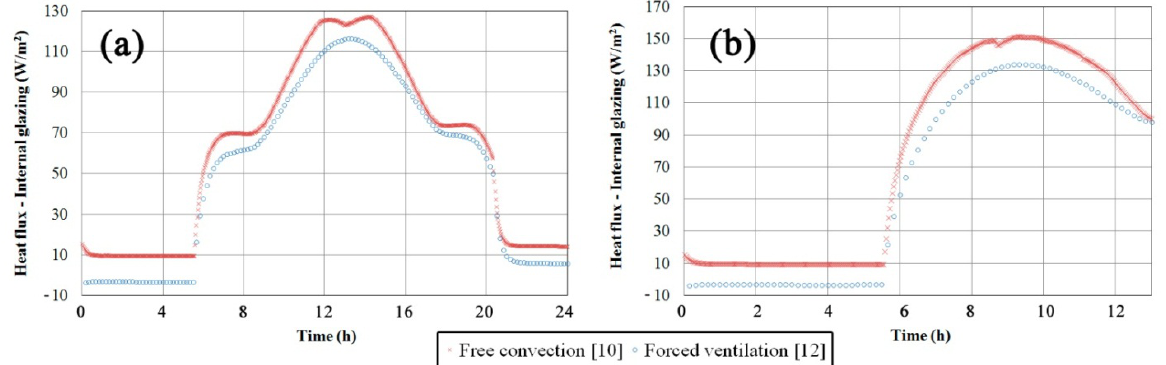
Figure 4. Results of heat flux inside the building obtained by Valentín et al. [13]. ( a ) South façade orientation; ( b ) East façade